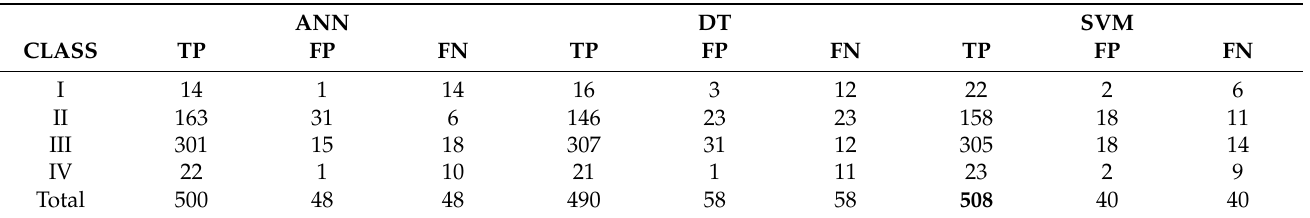
Table 10. Comparison of TP, FP (Type I error), and FN (Type II error) between ANN, DT, and SVM